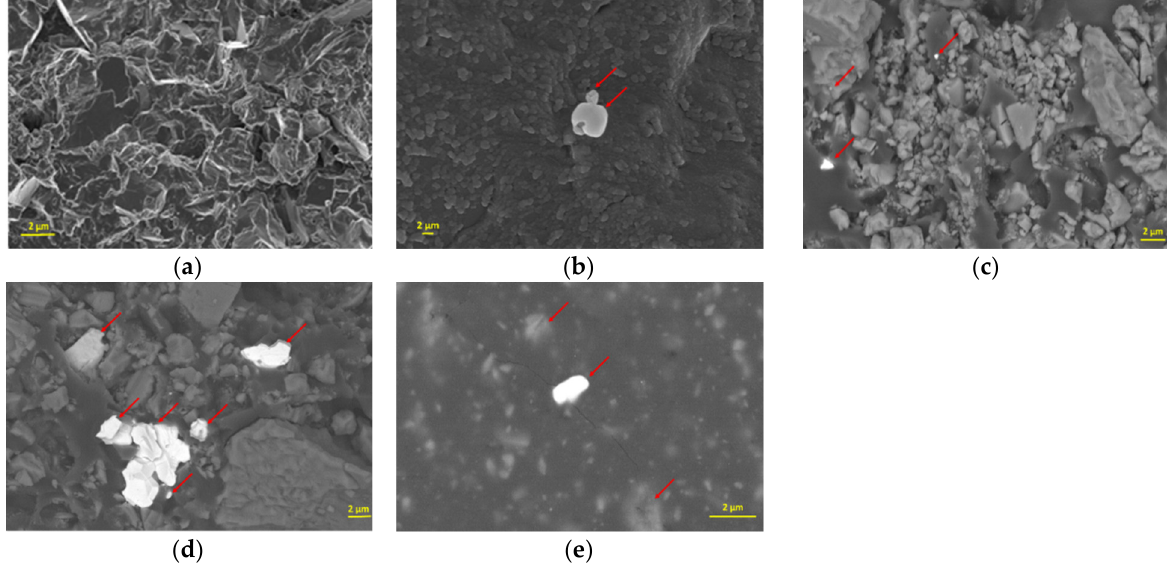
Figure 4. FESEM analysis of ( a ) blank sample. Sample obtained dispersing BiONPs with water in quantity of: ( b ) 1 wt. %; ( c ) 2 wt. %; ( d ) 4 wt. %. ( e ) Sample obtained without water using BiONPs in 2 wt. %. Red arrows indicate the BiONPs in the composite matrix.